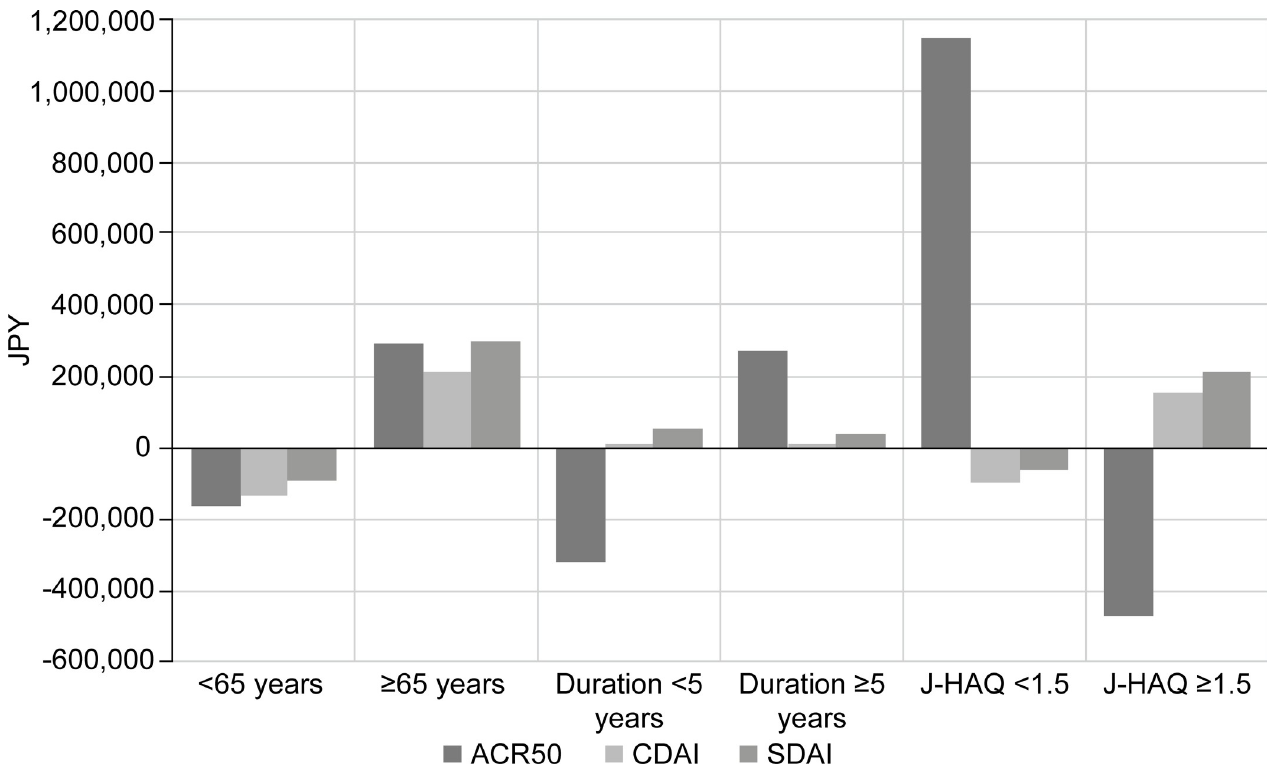
Fig 3. Scenario analyses: Differences in cost per patient achieving endpoints (ABA-1L vs. TNFi-1L). Difference in costs per health gain PMPM (ABA-1L – TNFi-1L). Costs per health gain PMPM were calculated by dividing total costs by the number of responders, patients in CDAI or SDAI remission for each group. The more positive the vertical axis, the more cost-effective the TNFi-1L was. 1L, first line; ABA, abatacept; ACR50, American College of Rheumatology response of at least 50% improvement; CDAI, Clinical Disease Activity Index; J-HAQ, Japanese version of Health Assessment Questionnaire; JPY, Japanese Yen; PMPM, per member per month; SDAI, Simplified Disease Activity Index; TNFi, tumour necrosis factor